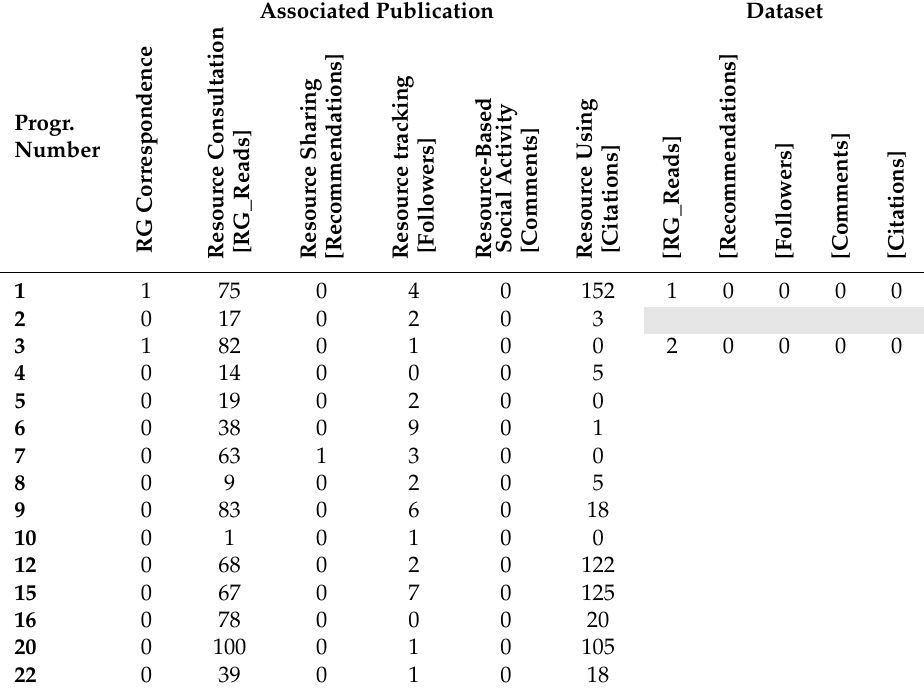
Table 4. ResearchGate metrics on social